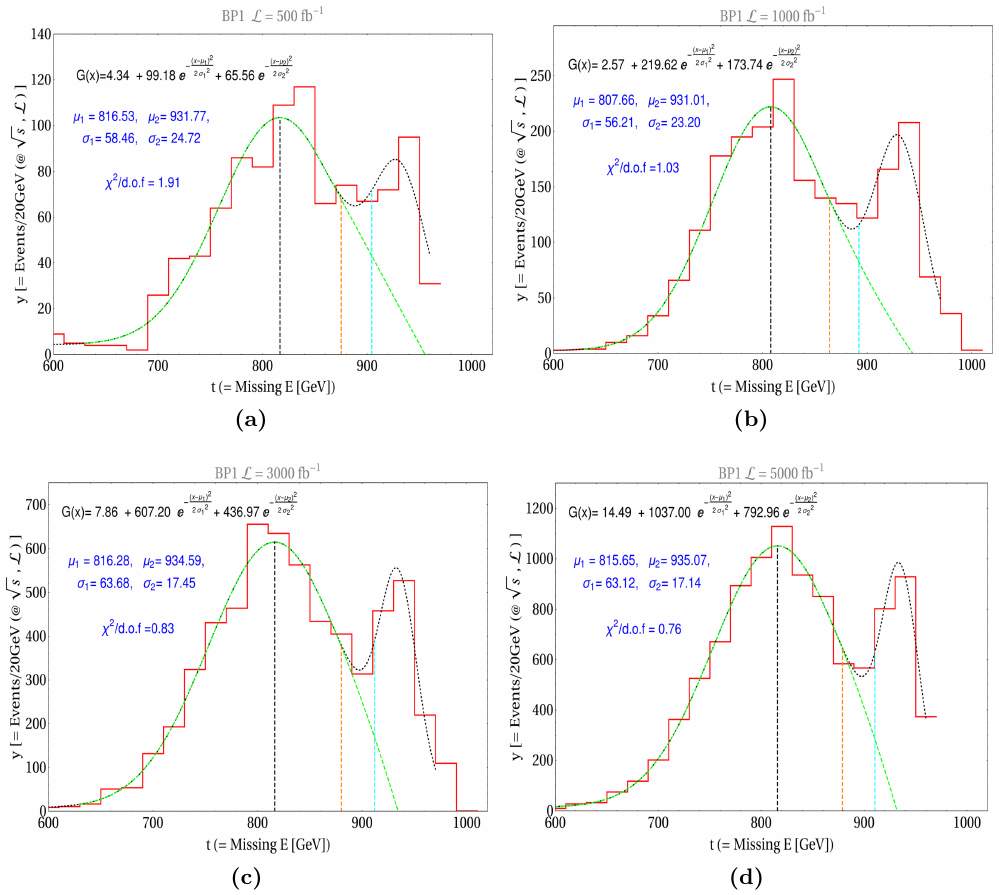
Figure 17. Gaussian Fitting of /E distribution for signal (BP1) plus SM background for different L . The polarization of initial beams are chosen to be